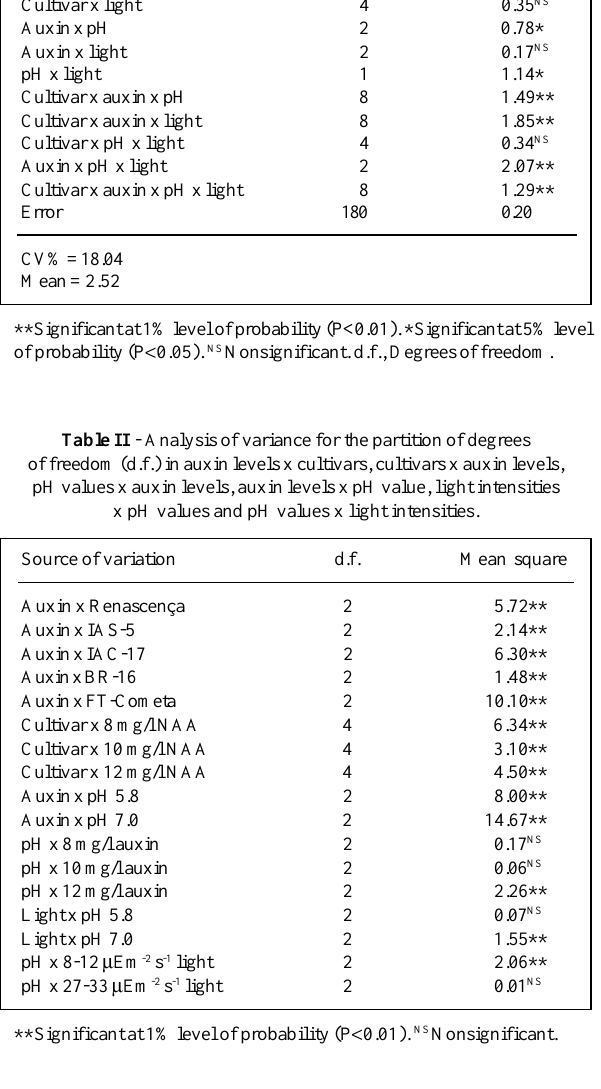
Table III - Means of somatic embryos (NE) obtained from cotyledons induced at two pH values and at two ligtht intensities.